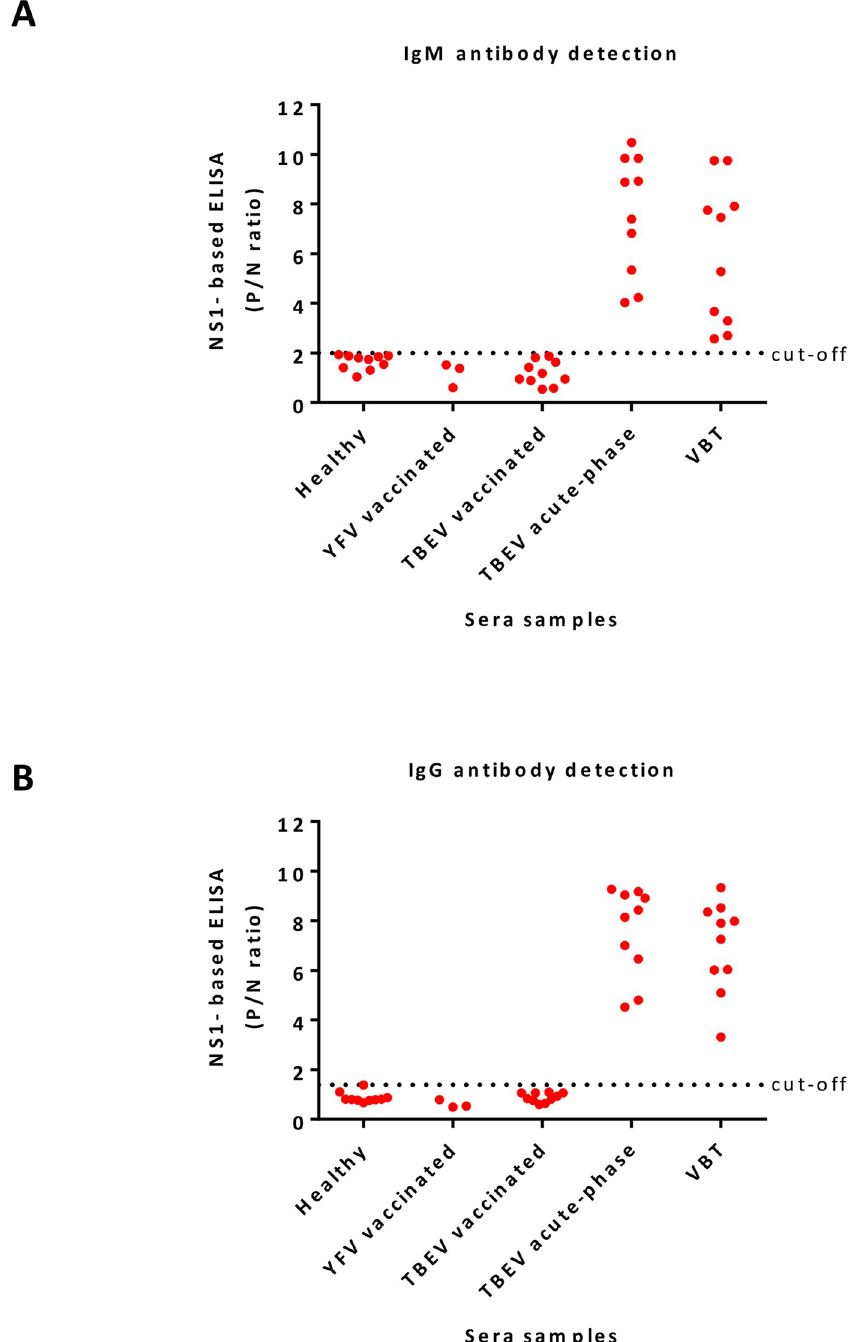
Fig 5. Differential serological diagnosis of TBEV. A and B) Detection of IgM (A) IgG (B) antibodies by TBEV rNS1-based ELISA using sera samples from five different groups of sera samples: 10 sera samples of healthy individuals from non-endemic TBEV regions and 3 sera from YFV vaccinated individuals (TBEV non-endemic areas) were used as controls. TBEV vaccinated group corresponds to 10 sera from individuals who got the vaccine (a suspension of purified TBE inactivated virus). The acute group corresponds to individuals with acute TBEV infection. The vaccine breakthrough (VBT) group corresponds to individuals who got the vaccine and were also infected with TBEV. � each ELISA result includes the average of two biological